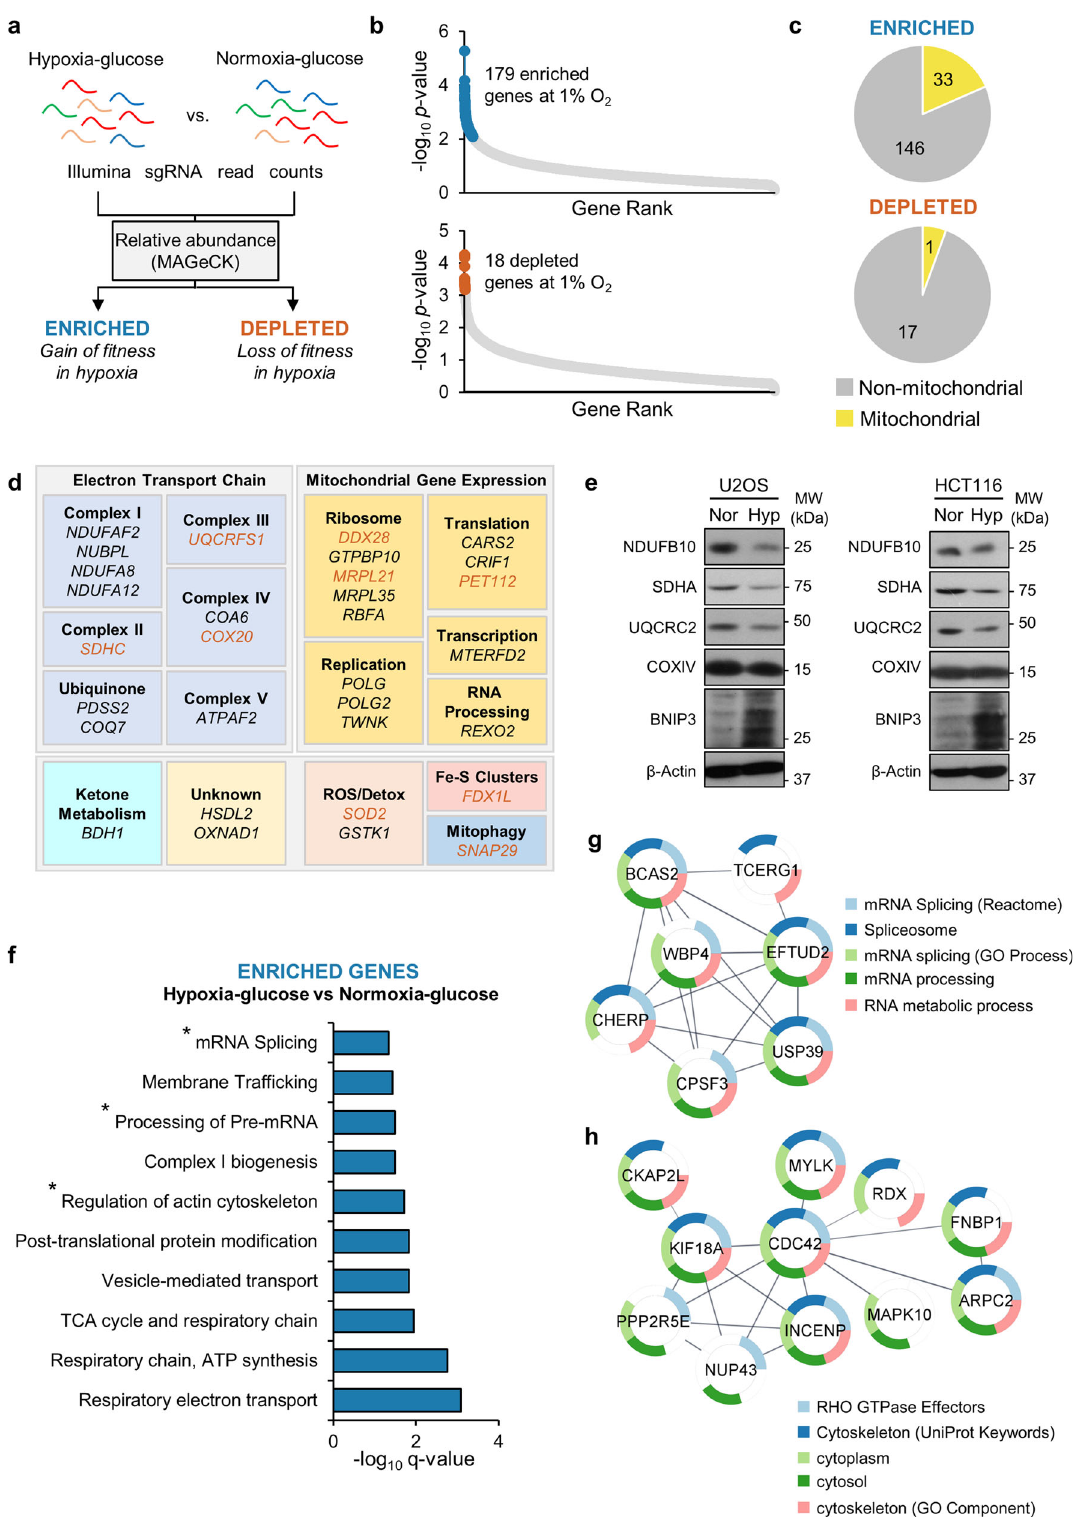
(Supplementary Fig. 6a) improved the growth of U2OS cells in hypoxia (Fig. 3b), demonstrating that the suppression of mito- chondrial function under hypoxia represents a survival response. We con fi rmed these fi ndings in two other tumour cell lines of different aetiologies, namely MCF7 (breast adenocarcinoma) and HeLa (cervical carcinoma) cells